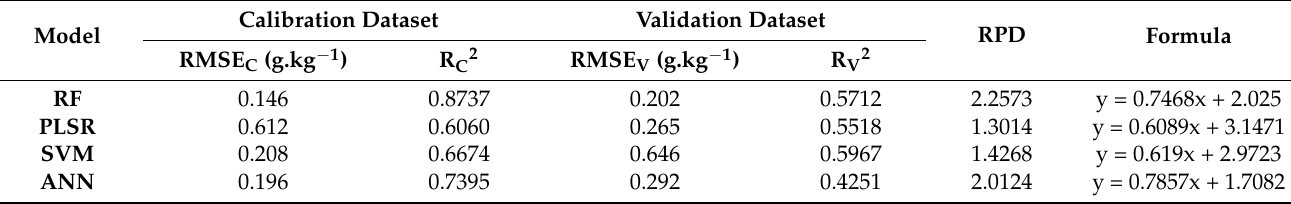
Table 5. Model prediction performance statistics for random forest (RF), partial least squares regression (PLSR), support vector machine (SVM), and artificial neural network models applied to spectral image data from the western Guanzhong Plain, China.